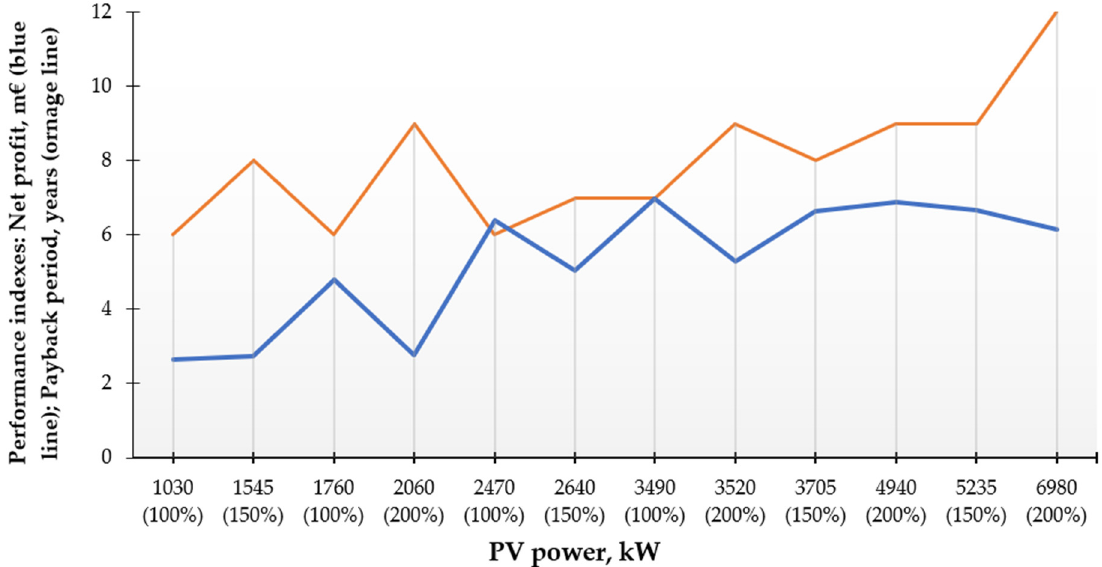
Figure 6. Net profit of prosumers and payback period results of analyzed scenarios for ECom depending on PV installed power.